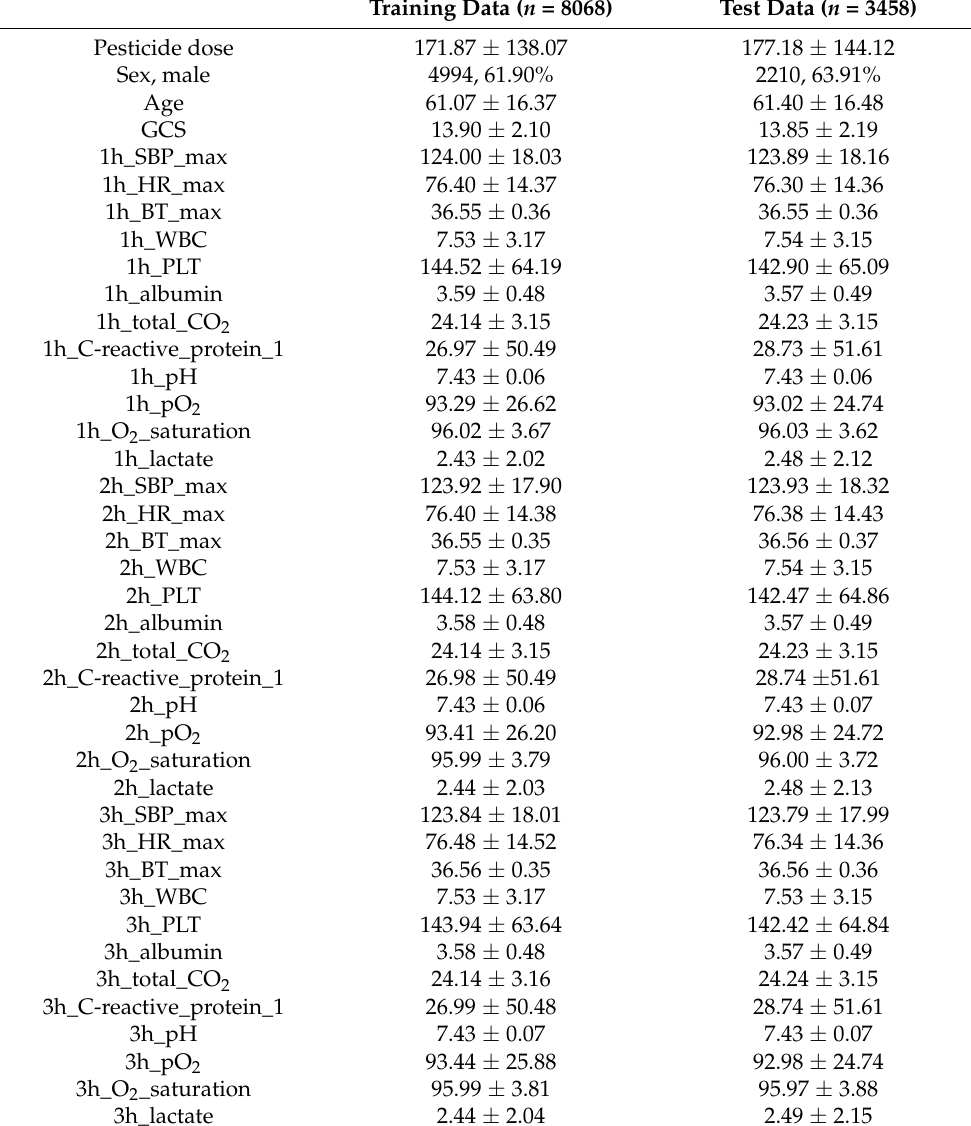
Table 6. The characteristics of our